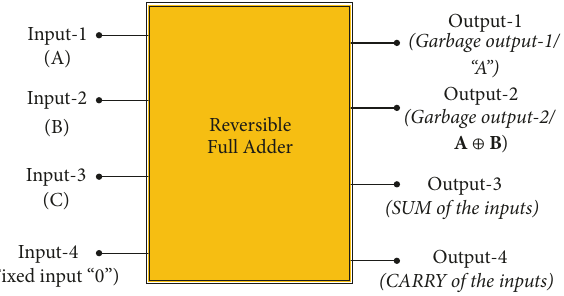
Figure 12: Block diagram of reversible full adder